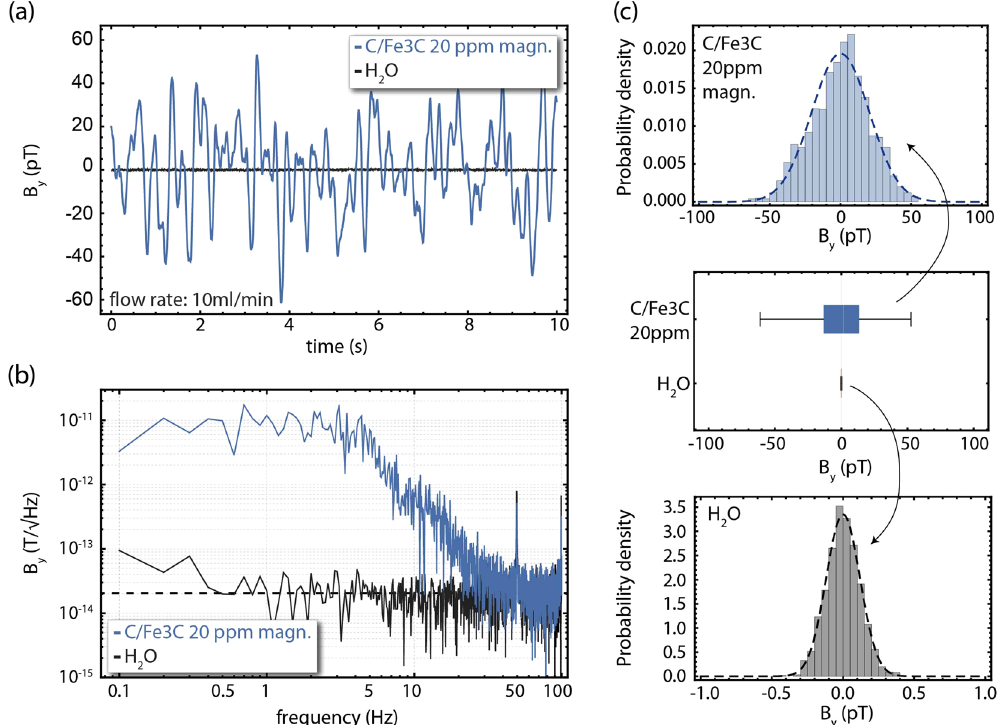
Figure 2. Detection of C/Fe 3 C ferromagnetic particles in water solutions. ( a ) Real time magnetic-field measurements along the y-axis for pure water (black points) and 20 ppm:water solution of pre-magnetized C/ Fe 3 C nanoparticles (blue points). ( b ) Magnetic field power spectra for the measurements presented in ( a ). The black dashed line corresponds to 20.4 fT/ Hz (averaged from 1–100 Hz), indicating the noise floor baseline of the measurement and verifying that the presence of the water does not influence significantly the magnetometer’s sensitivity. ( c ) Histogram analysis of the measurements shown in ( a ) and ( b ), including a box- and-whisker plot analysis for visual comparison of the observed magnetic-field distributions (the white line represents the median marker, the grey boxes the upper and lower 25% quantiles, while the grey bars represent the maximum and minimum acquired data points, including data outliers). For the histogram analysis we employ a digital filter to remove the 50 Hz and 100 Hz power-line-related noise components. All measurements are performed under constant flow conditions, with a flow rate of 10 ml/min.